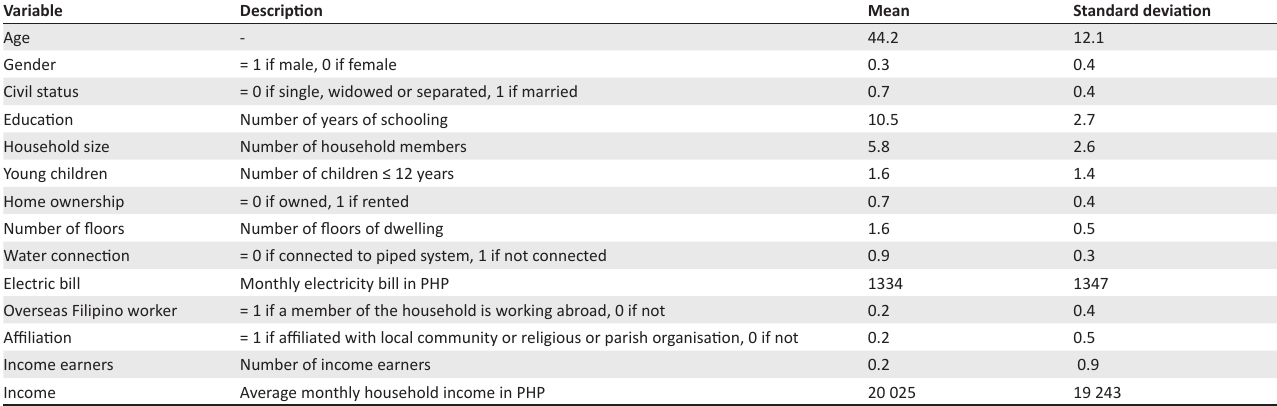
TABLE 3: Respondent and household characteristics.